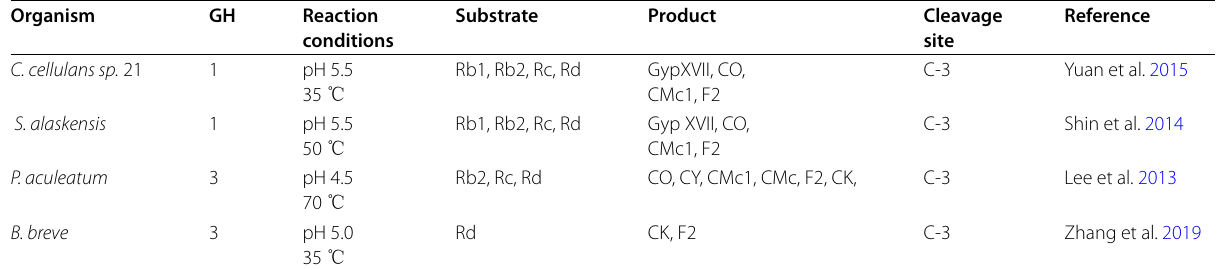
Table 5 The recombinant β-glucosidases act on the C3 sugars in Rb1, Rb2, Rc or Rd